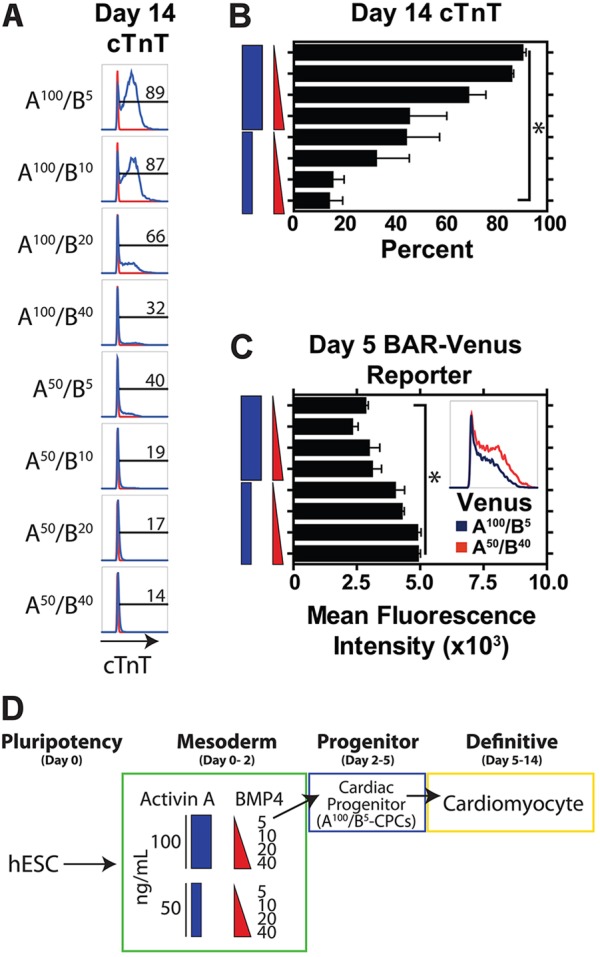
High activin A and low BMP4 concentrations direct cardiac differentiation. (A,B) Flow cytometry for cTnT on day 14 of differentiation across the range of differentiation conditions defined by doses of activin A and BMP4, with raw histograms (A) and mean data across five biological replicates (B) showing the highest efficiency of cardiac differentiation (percentage cTnT+ cardiomyocytes) in conditions of A100/B5. (C) Wnt/β-catenin signaling activity as measured by the BAR-Venus reporter in day 5 CPCs under different doses of activin A and BMP4. Inset shows raw flow cytometry plot of Venus activity in A100/B5 versus A50/B40 CPCs. (D) Schematic illustrating that cardiomyocytes are generated optimally from A100/B5 CPCs. n=5 biological replicates. *P<0.05.